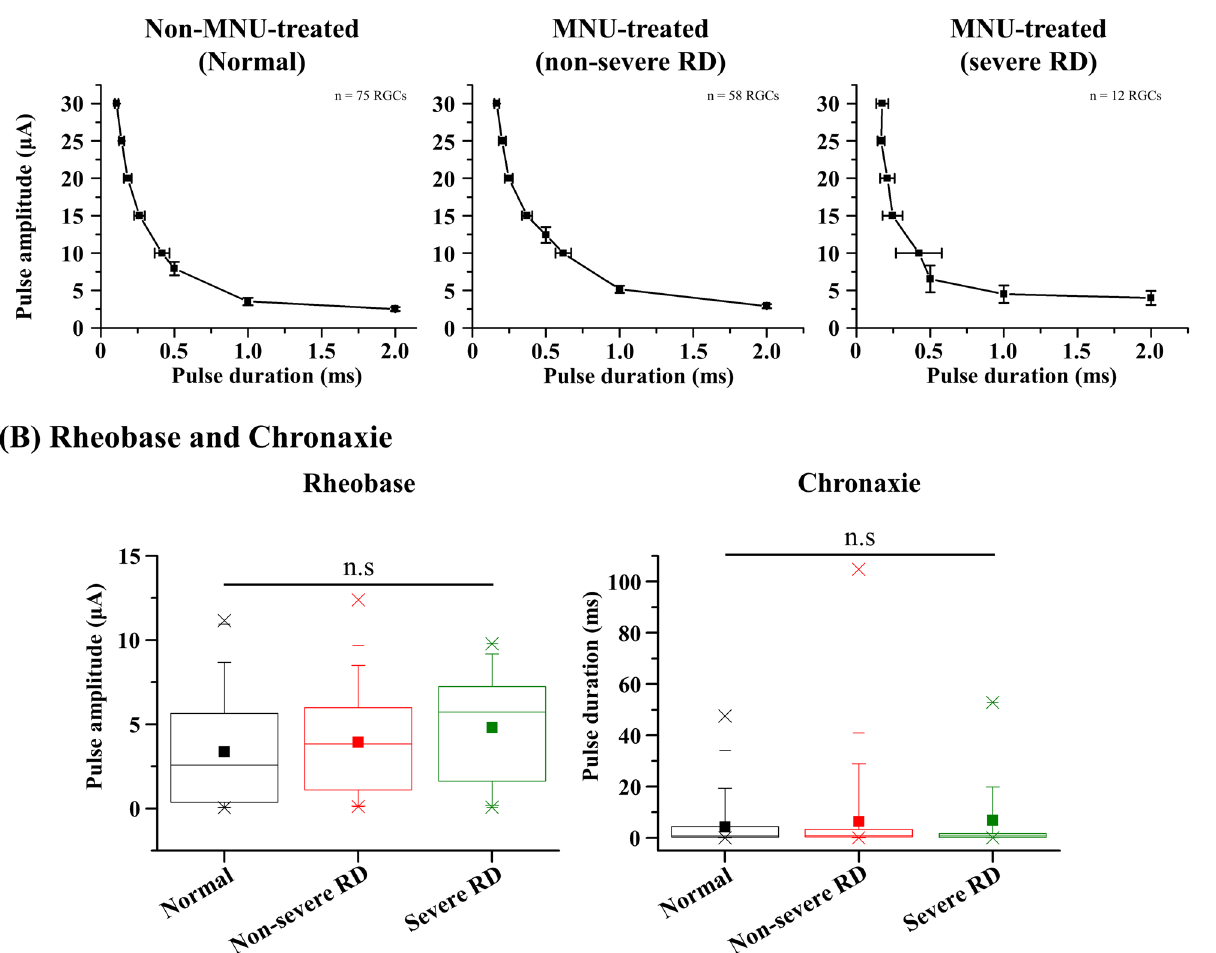
Figure 6. Strength-duration (SD) curve. ( A ) Averaged SD curves of well-modulated RGCs from three different groups. ( B ) Rheobase (left) and chronaxie (right) values calculated from individual well-modulated RGCs. Each SD curve is fitted with hyperbolic functions. Statistical significance among the three groups analyzed using ANOVA ( n.s p >